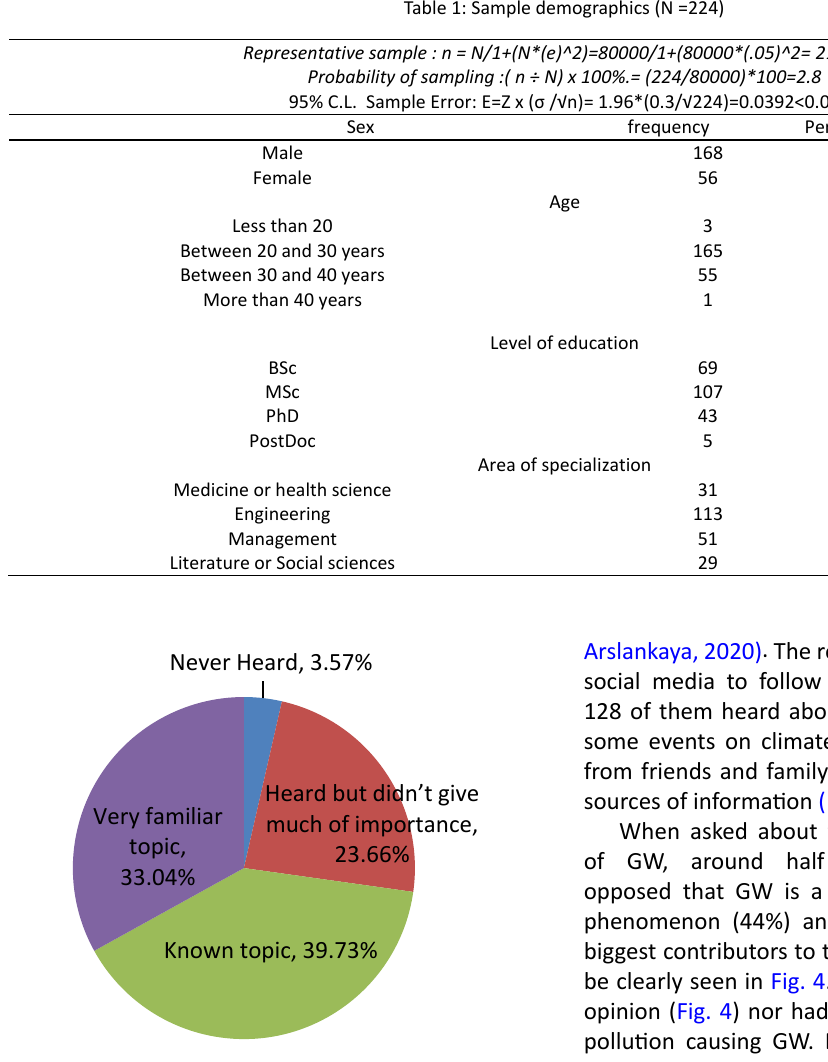
Fig. 2: Respondent’s awareness level on GW